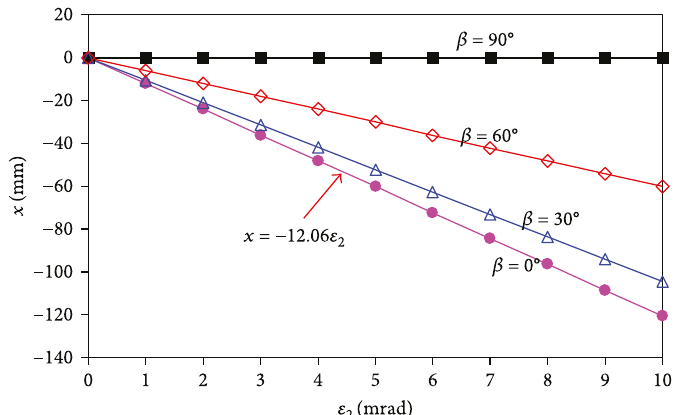
Figure 9: The relationship between the centroid movement distance of the focal spot and azimuth tracking error of the